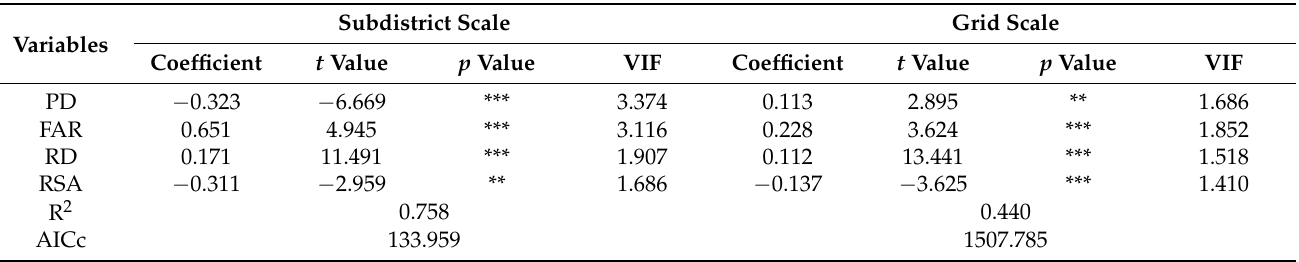
Table 15. OLS regression results at the subdistrict scale and grid scale (ln(Night_V) as the dependent